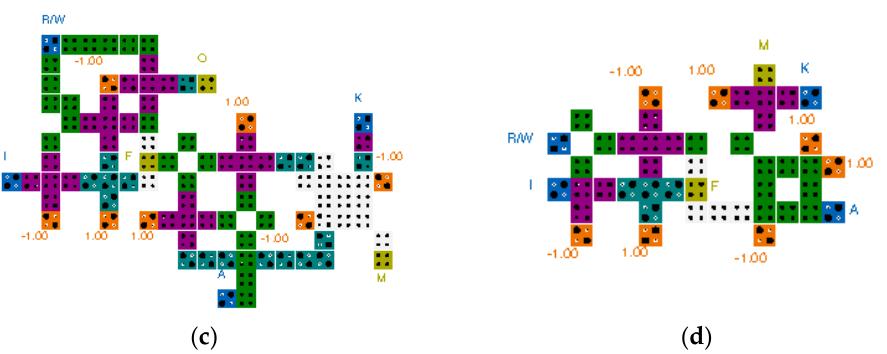
Figure 8. Conventional QCA CAM cells: ( a ) L. H. B. Sardinha et al.’s [44]; ( b ) S. R. Heikalabad et al.’s [45]; ( c ) M. B. Khosroshahy et al.’s [46]; ( d ) A. Sadoghifar et al.’s [47].